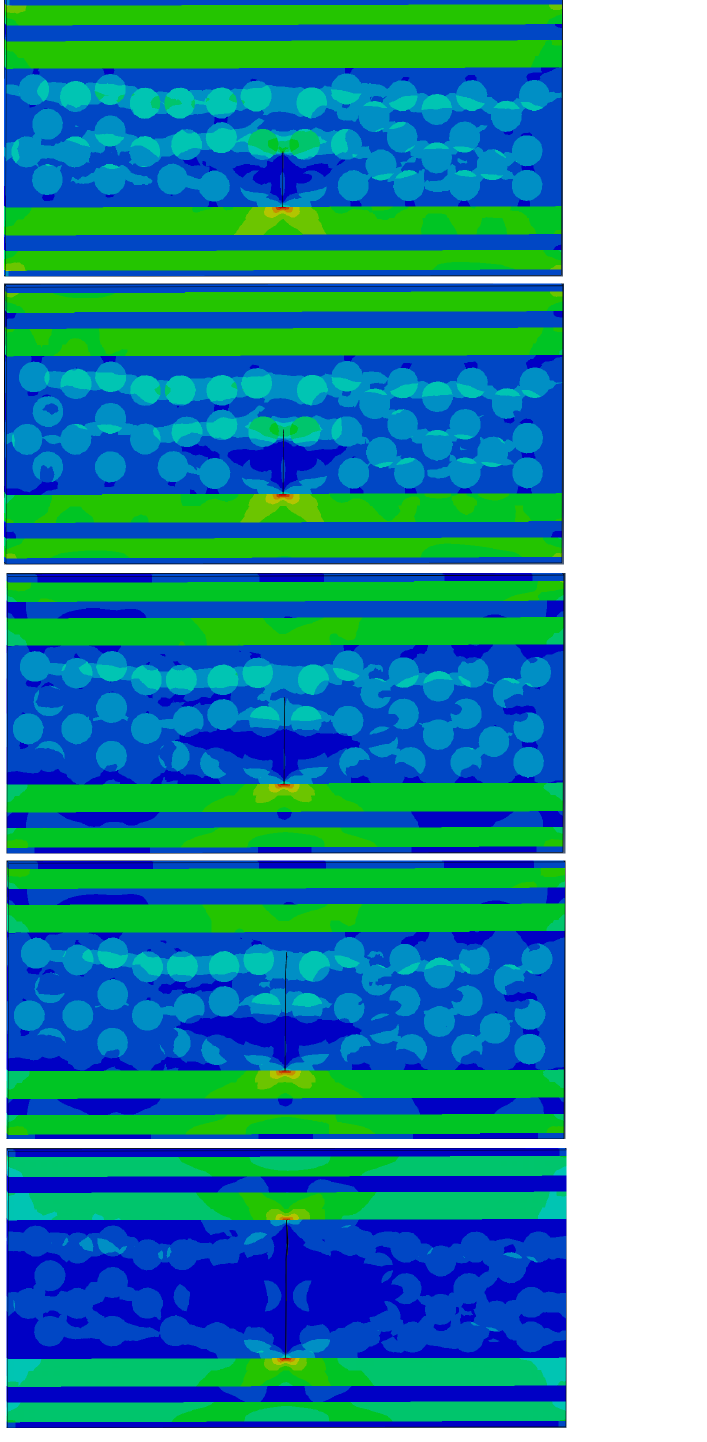
Figure 10. Crack growth in a cross-ply RVE using